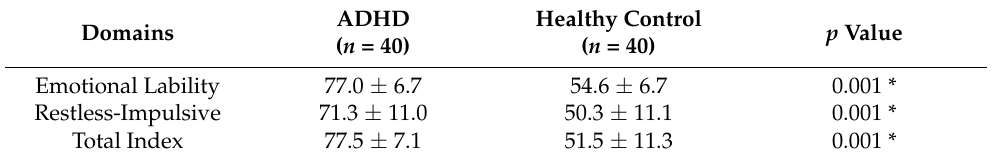
Table 2. Comparison of Conners’ Global Index—Parent version domains between ADHD and control group.